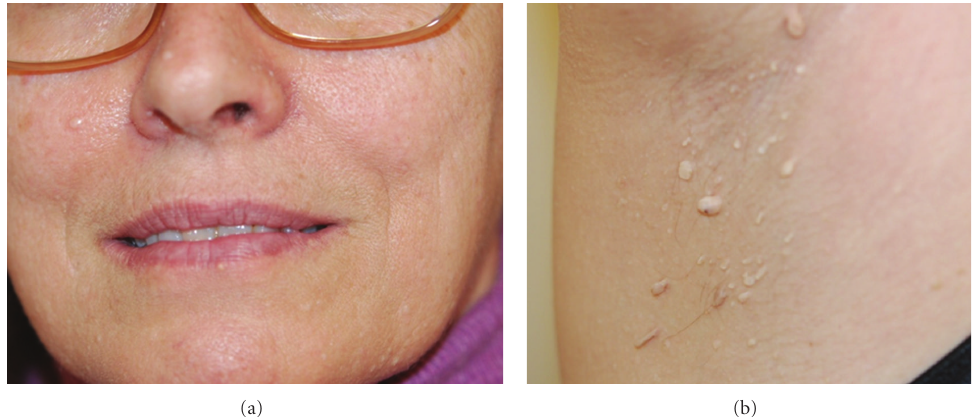
Figure 3: (a) Multiple, asymptomatic, white, dome-shaped, firm papules over the face. (b) Multiple skin colored, soft, pedunculated papules on the axillae (acrochordons).